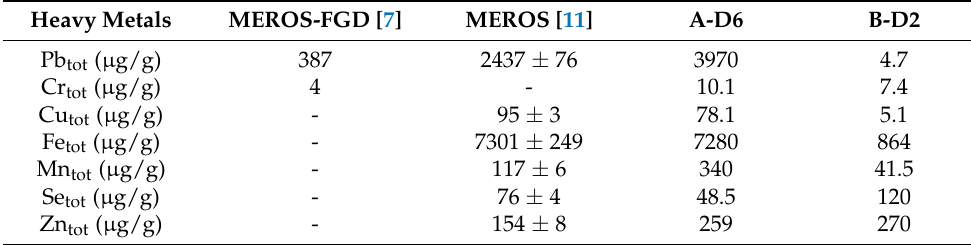
Table 3. Comparison of MEROS dust samples data in the literature.